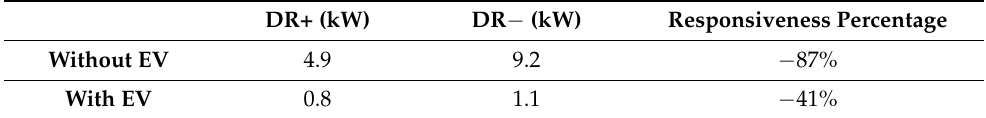
Table 1. The effectiveness of EV on DR. DR+ (kW) DR − (kW) Without EV With EV − 41%